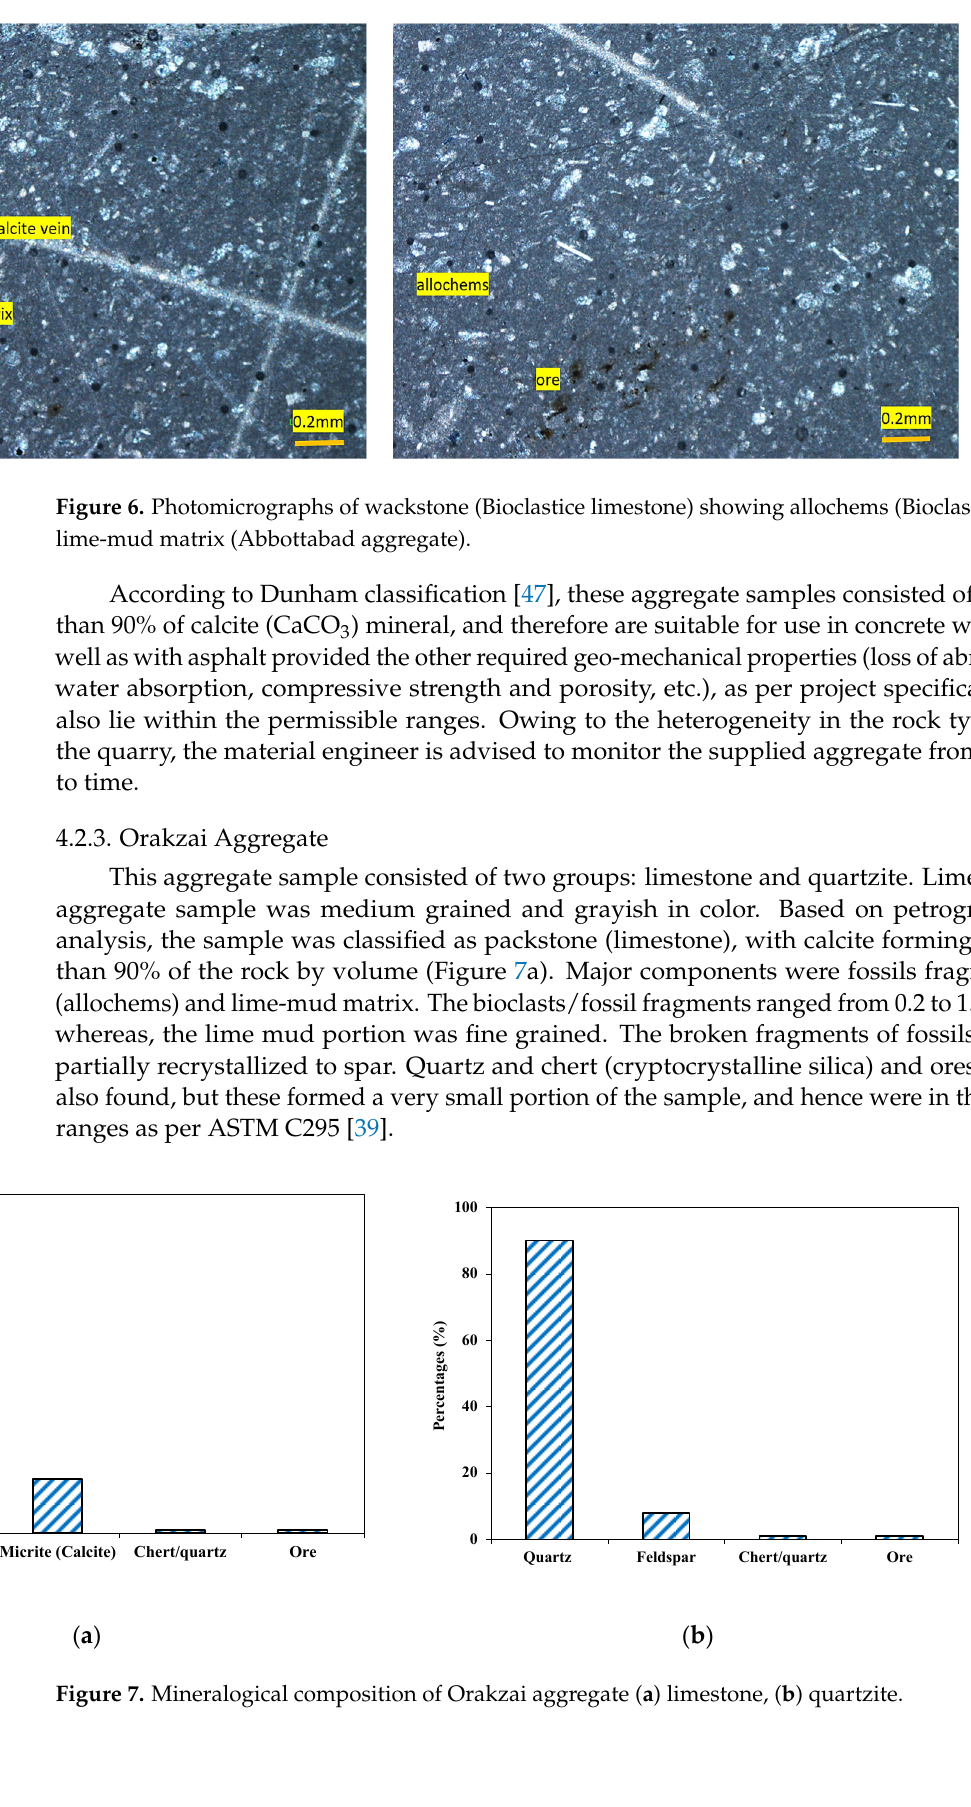
Figure 5. Mineralogical composition of Abbottabad aggregates.